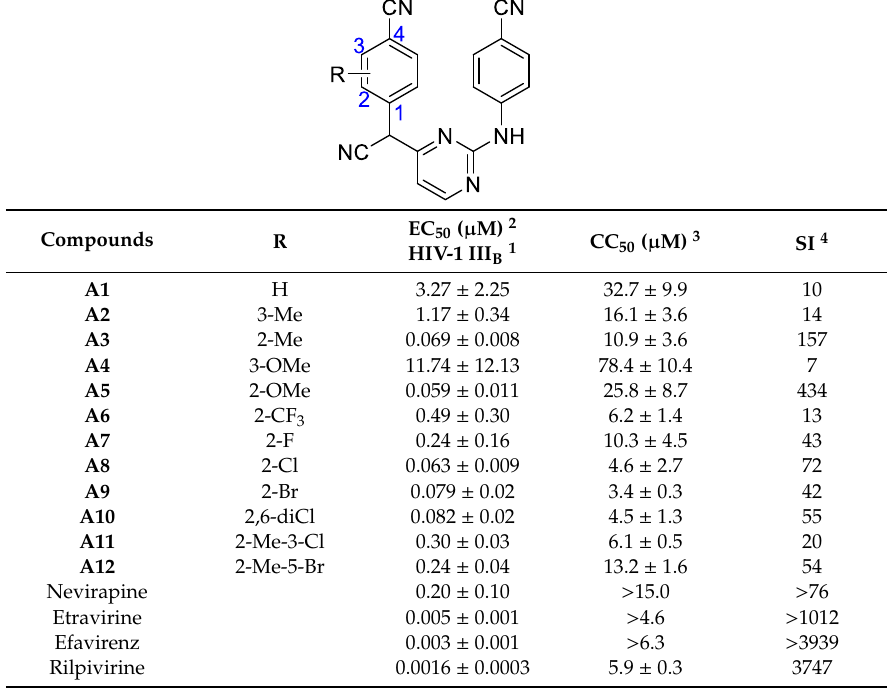
Table 1. Activity and cytotoxicity against HIV-1 (III B ) strains in MT-4 cells of compounds A1 – A12 .